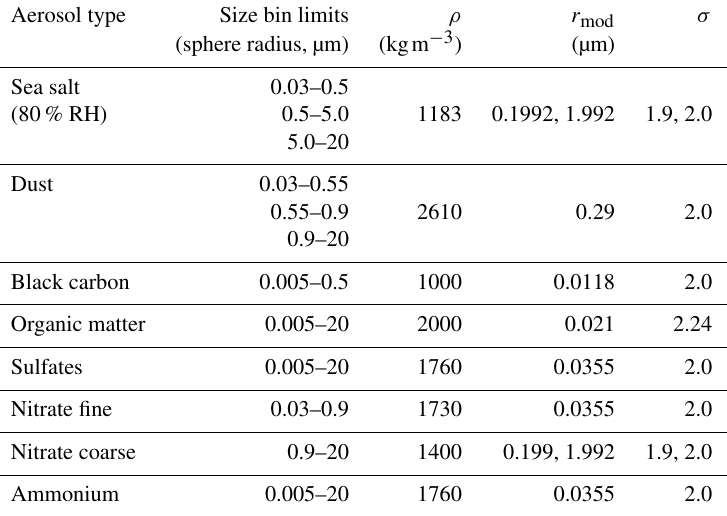
Table 1. Aerosol species and parameters of the number size distribution associated to each aerosol type in IFS-AER ( r mod is mode radius, ρ is particle density and σ is geometric standard deviation). Values are for the dry aerosol, with the exception of sea salt, which is given at 80% RH. The number size distribution is assumed to be monomodal for all species except sea salt and coarse-mode nitrate for which a bimodal size distribution is